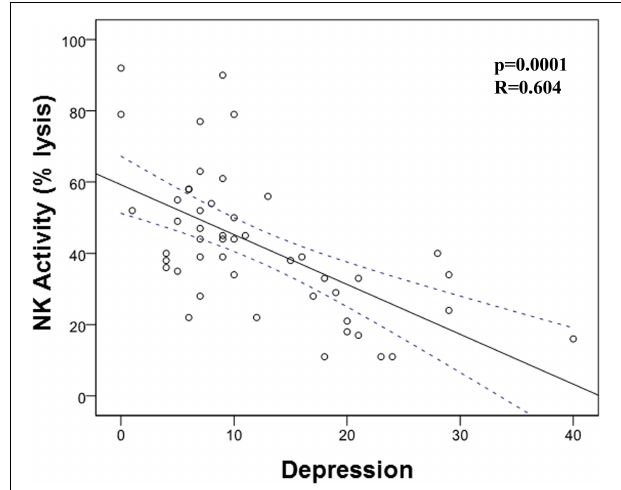
FIGURE 4 | Correlation between natural killer (NK) cell activity and depression. There is a significant correlation between NK activity and depression ( p = 0.001; R = -0.604).